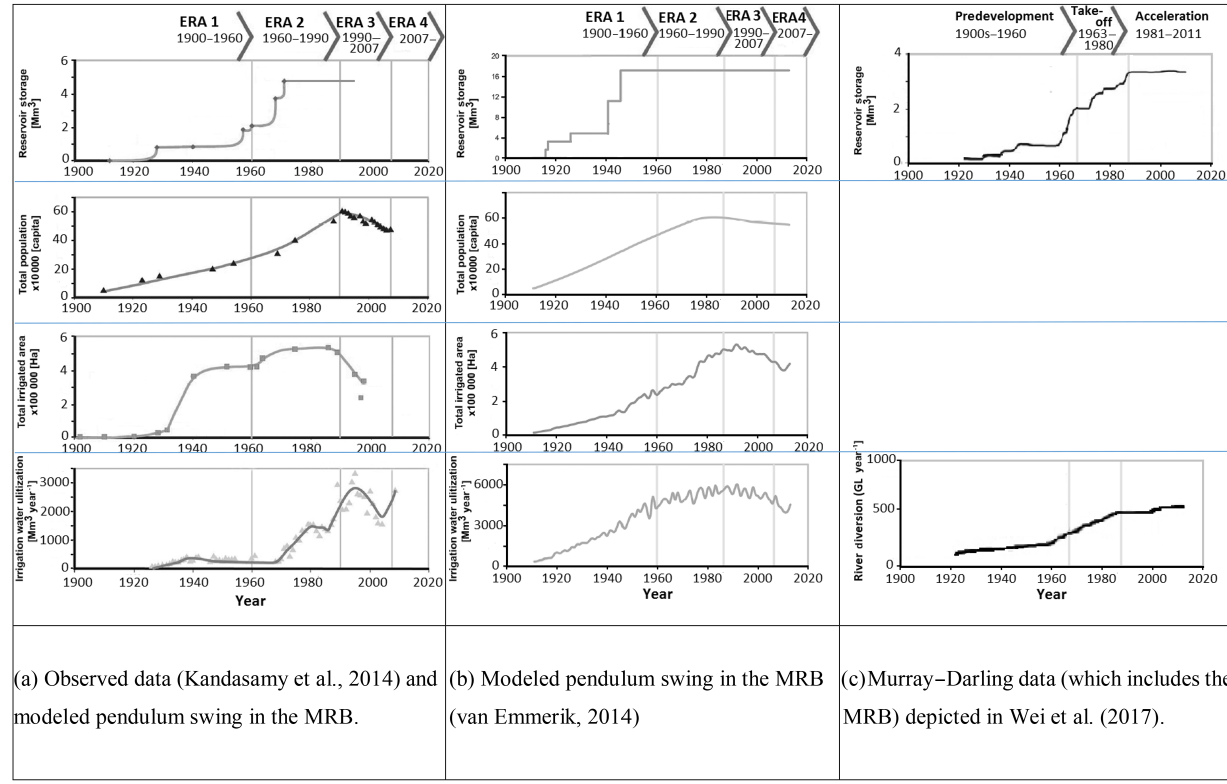
Figure 3. Observed and modeled pendulum swing in the MRB during the period 1910–2013. Era 1 (1900–1980): expansion of agriculture and associated infrastructure; Era 2 (1960–1990): onset of environmental degradation; Era 3 (1990–2007): establishment of widespread environmental degradation; Era 4 (2007–2014): remediation and emergence of environmental customer. The eras correspond to phases in Elshafei et al. (2015): expansion (1911–1960) – aggressive rate of expansion and active modification of water balance; contraction (1960s) – plateau in anthropogenic modification; recession (1970–2002), cumulative negative impacts on economic and environmental well-being; recovery and new equilibrium (2002–present) – adoption of remedial measures; and in Wei et al. (2017): predevelopment (1900s–1960s) – societal values dominated by economic development; take-off (1963–1980) – societal values reflected increasing environmental awareness due to outbreak of pollution events; acceleration (1981–2011) – growing shift in societal values towards environmental